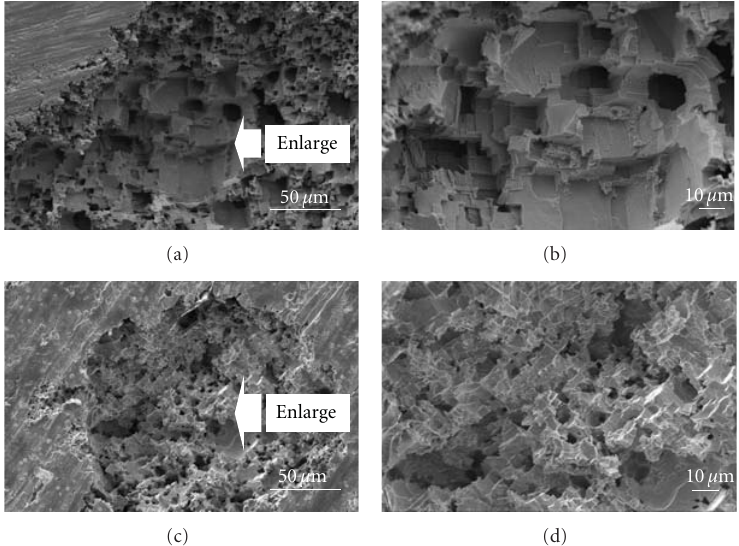
Figure 4: Morphology of Al after anodic oxidation for 5min at 0.3V nobler than the pitting corrosion potential in a solution containing 0.1mol · dm − 3 of Na 2 SO 4 and 300 ppm of Cl − . (a, b) Pure Al without ECAP. (c, d) Pure Al with